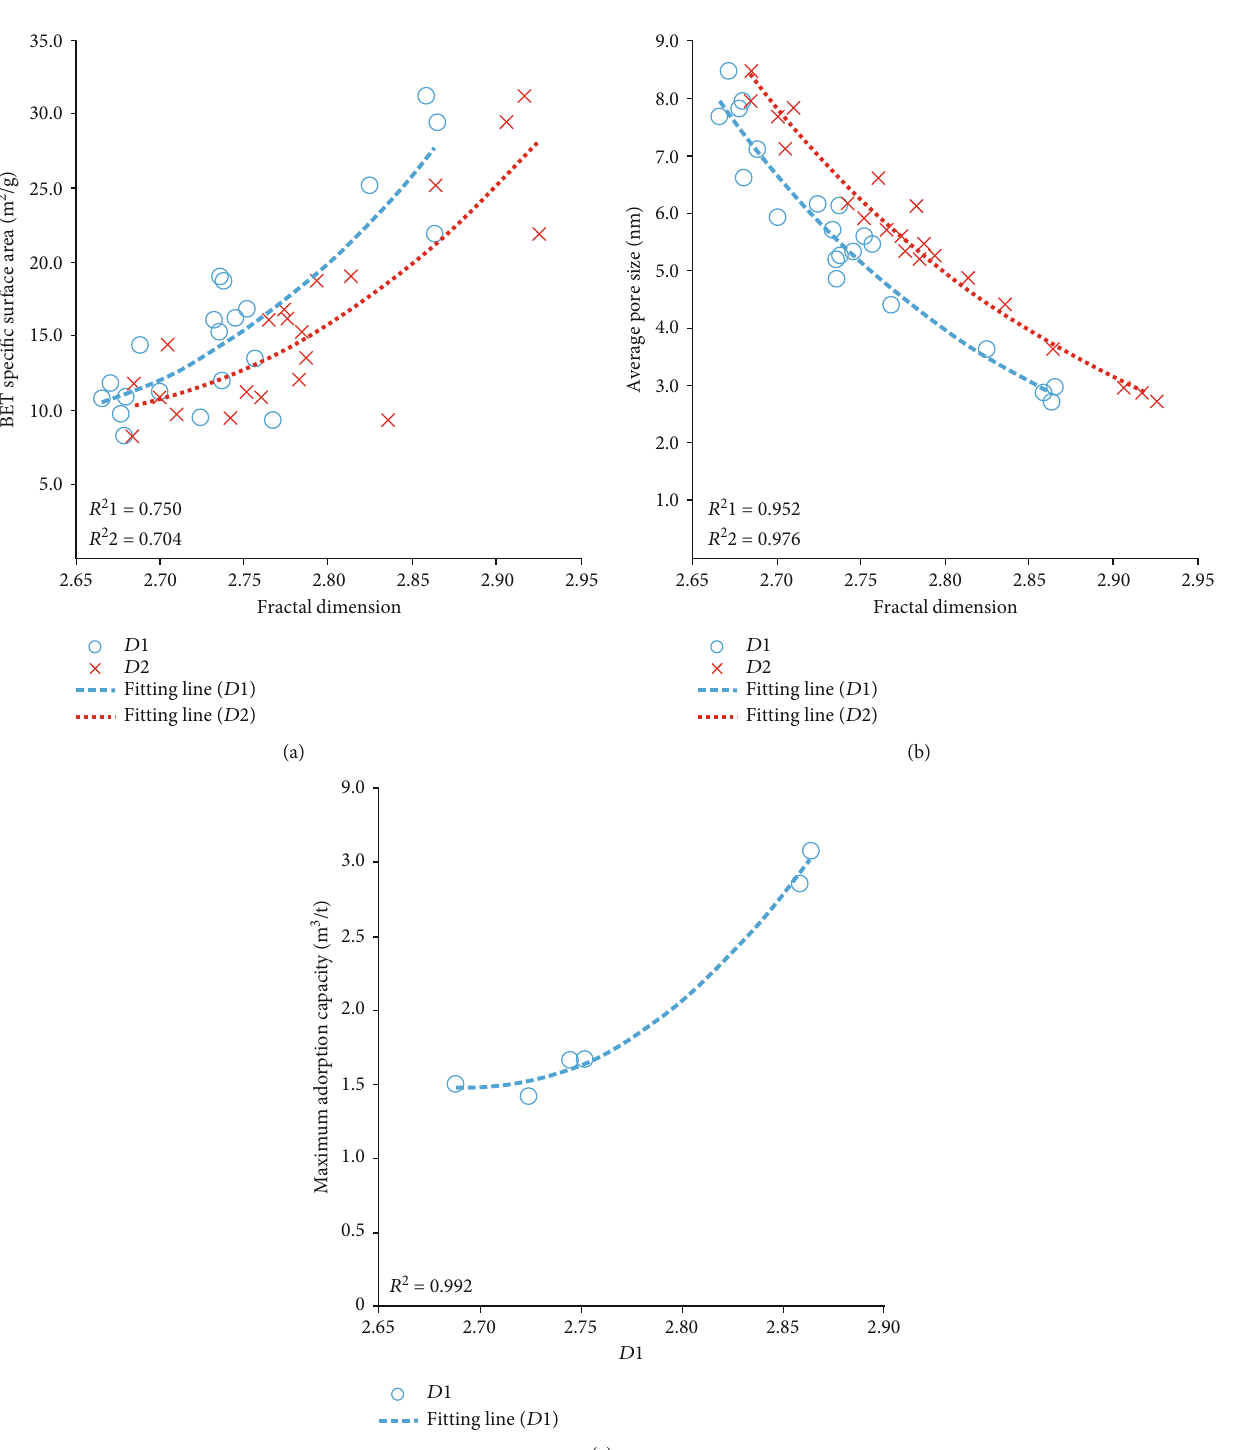
Figure 7: Correlation among BET speci fi c surface (a), average pore size (b), adsorption capacity (c), and fractal dimensions of Longtan